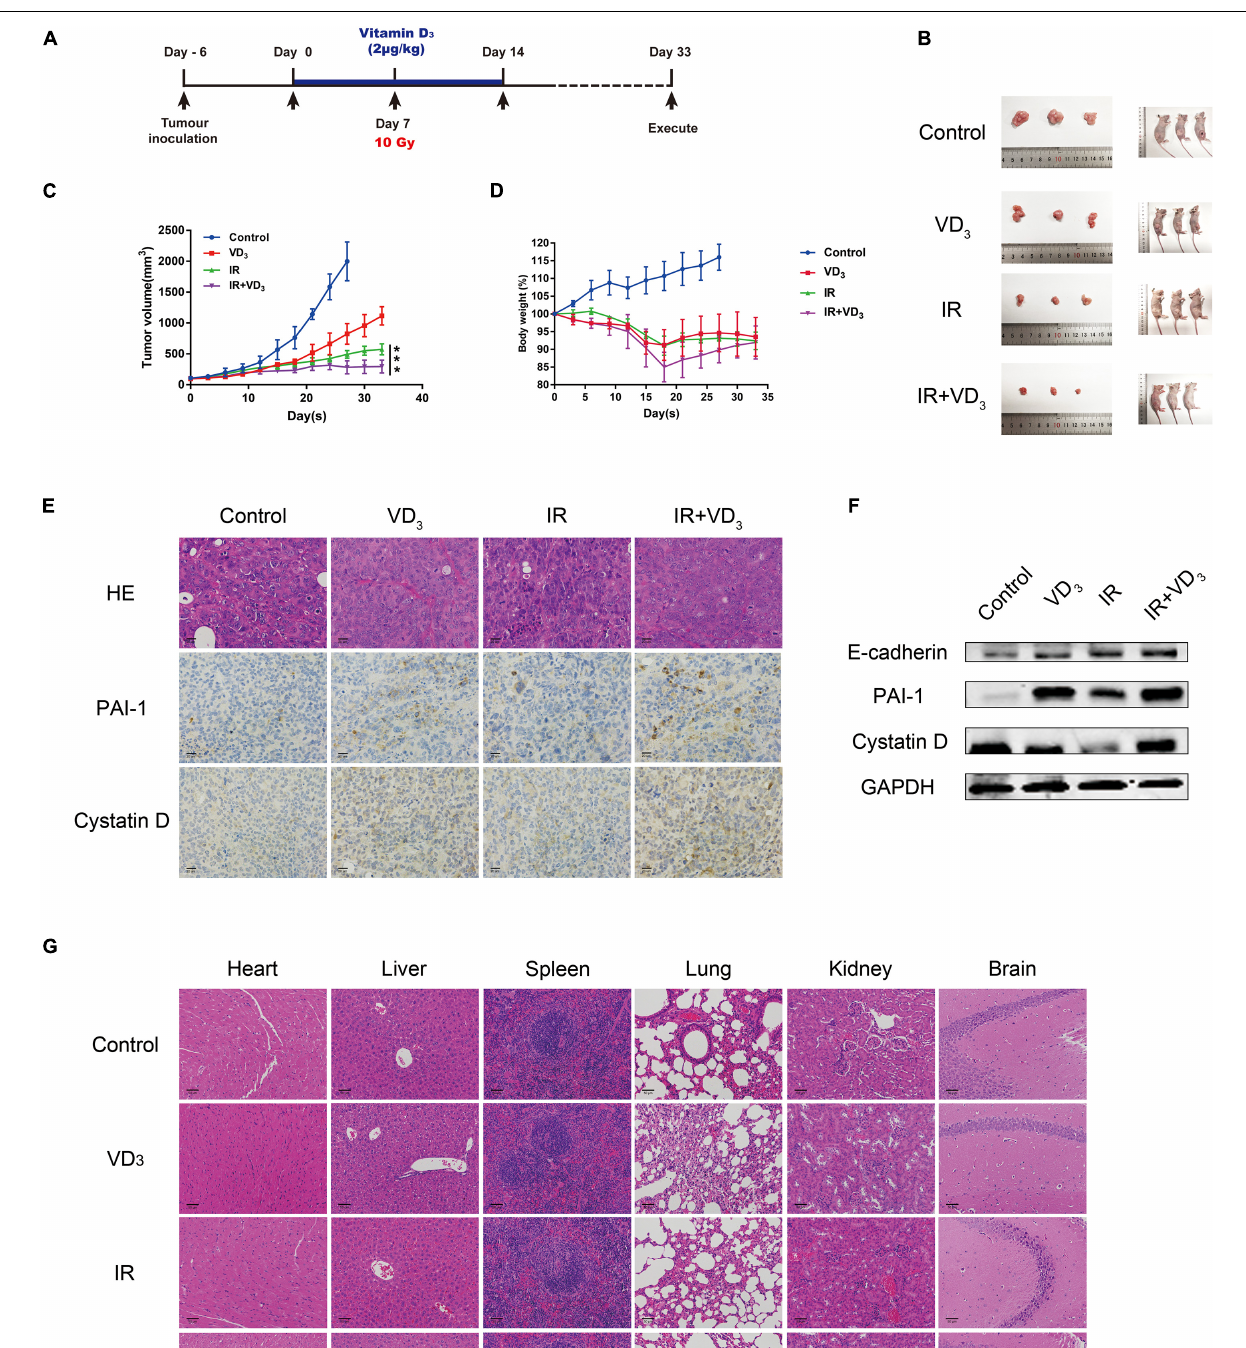
Frontiers in Cell and Developmental Biology |